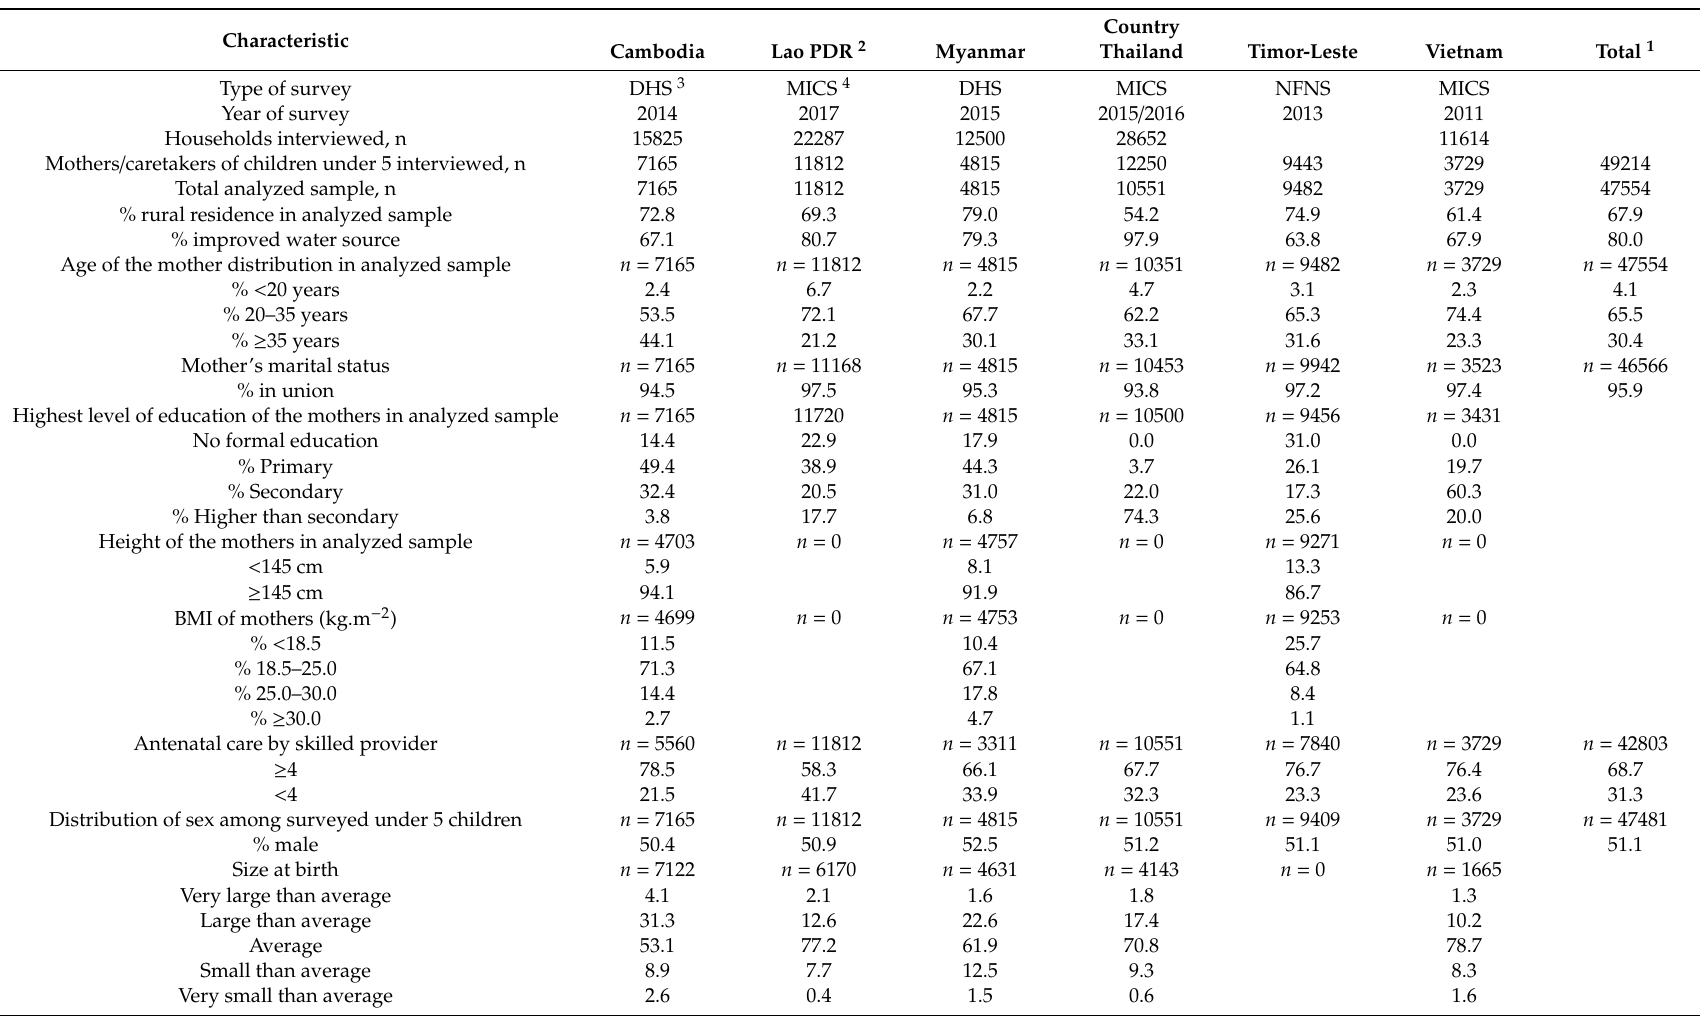
Table 1. Selected households, mothers and children characteristics by